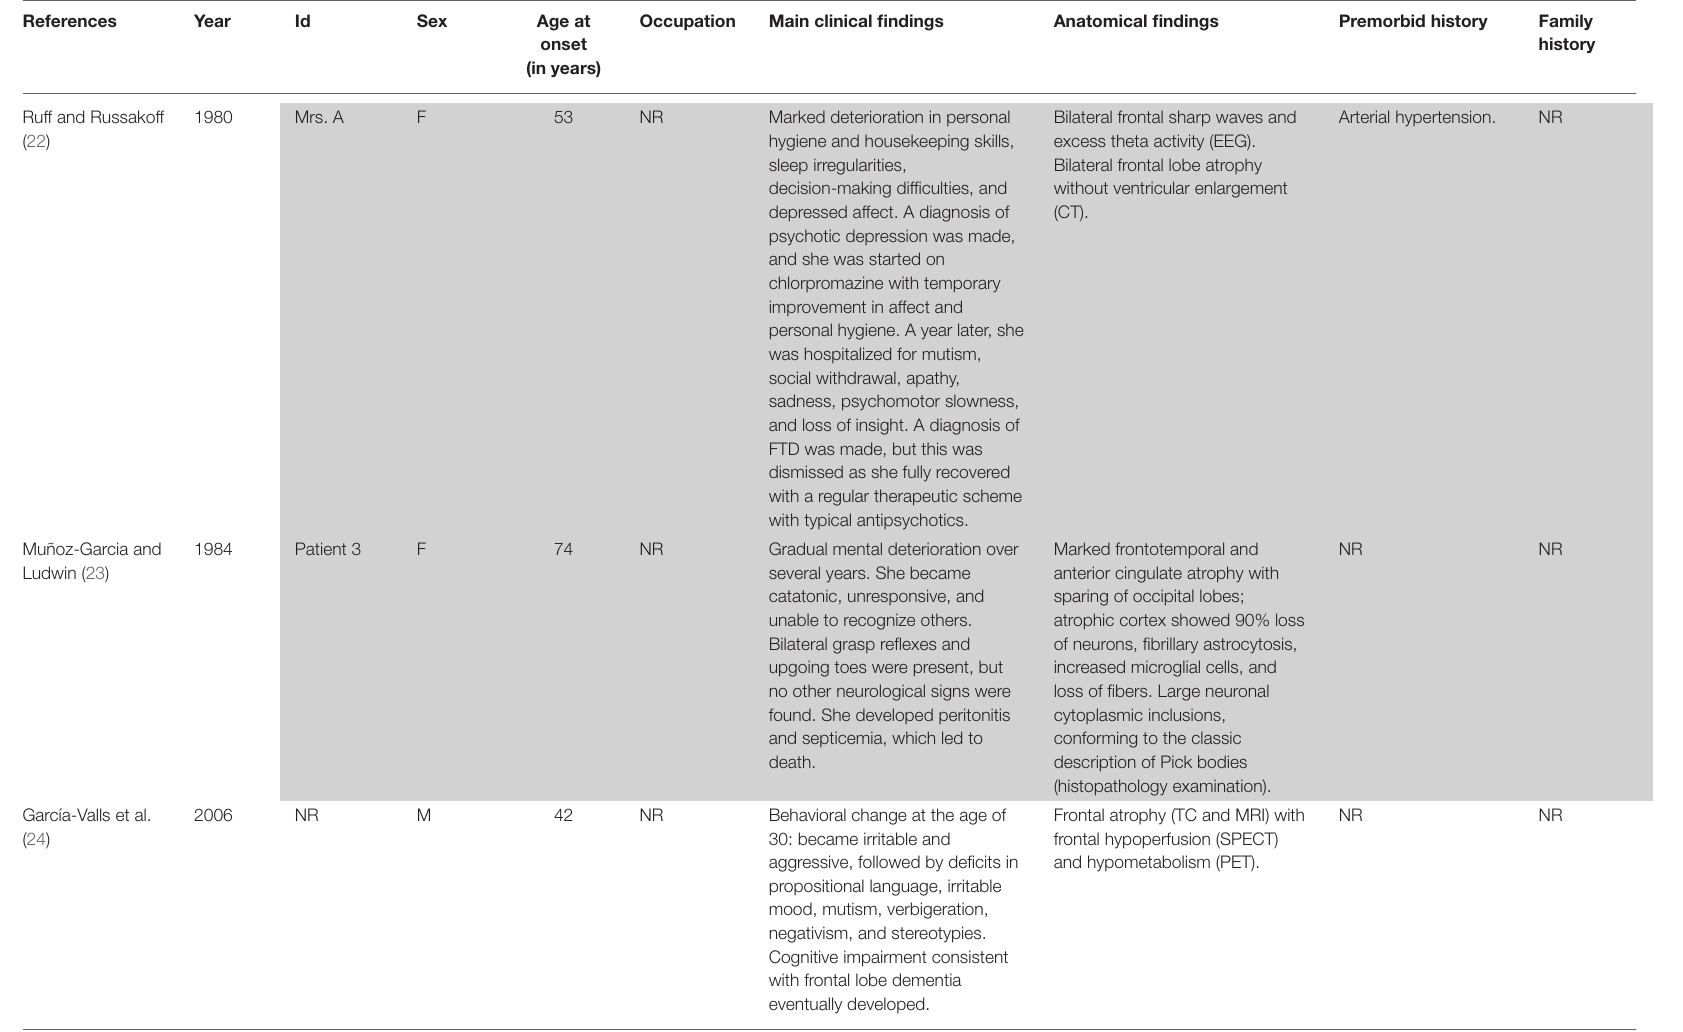
TABLE 1 | Catatonia in frontotemporal atrophy (cases of catatonic stupor highlighted in